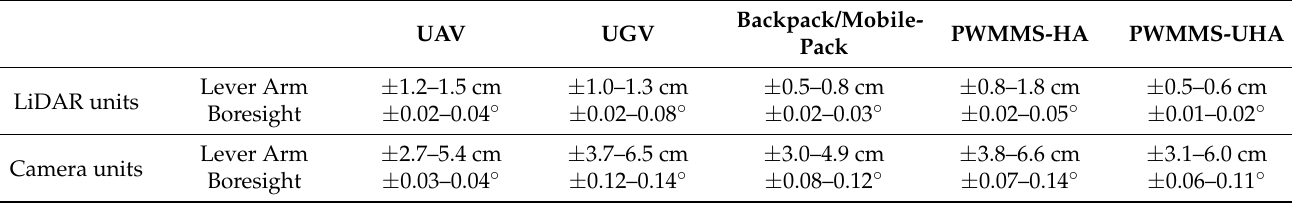
Table 2. The range of standard deviation of the estimated system mounting parameters for all the LiDAR/camera units onboard each MLMS.